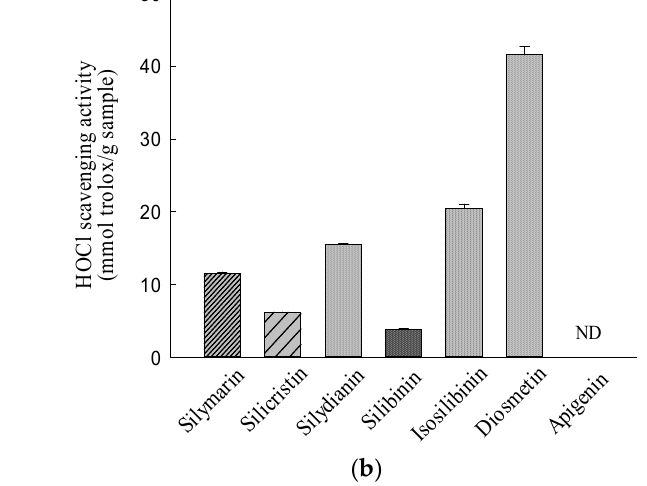
Figure 5. HClO-scavenging activities of the methanolic standardized extracts of Cirsium species and Cirsii Herb. ( a ) The methanolic standardized extracts of Cirsium species and CH; ( b ) all ingredients of the methanolic standardized extracts of Cirsium species and CH. Data are expressed as means ± SD (n = 3). ND: non-detected. CAA, the aerial part of C. arisanense ; CAF, the flower part of C. arisanense ; CAR, the radix part of C. arisanense ; CBA, the aerial part of C. brevicaule ; CBR, the radix part of C. brevicaule ; CFA, the aerial part of C. ferum ; CFF, the flower part of C. ferum ; CHOA, the aerial part of C. hosokawae ; CJA, the aerial part of C. japonicum DC. var. australe ; CJF, the flower part of C. japonicum DC. var. australe ; CJR, the radix part of C. japonicum DC. var. australe ; CKA, the aerial part of C. kawakamii ; CKR, the radix part of C. kawakamii ; CLA, the aerial part of C. lineare ; CLF, the flower part of C. lineare ; CLR, the radix part of C. lineare ; CH, Cirsii Herb; HOCl, hypochlorite acid. Bars with different letters indicate statistical significances, p < 0.05.